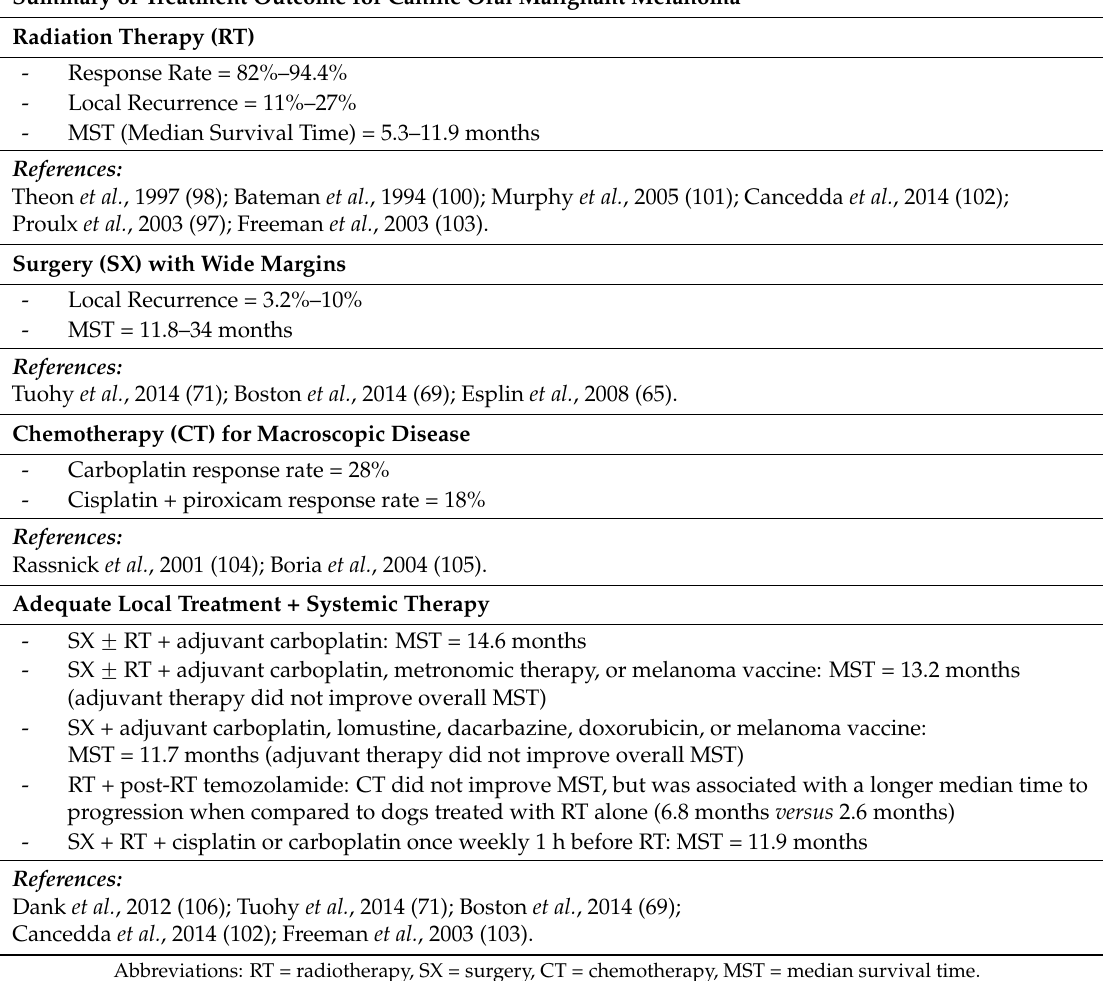
Table 4. Outcomes for canine oral malignant melanoma after different therapeutic protocols. Summary of Treatment Outcome for Canine Oral Malignant